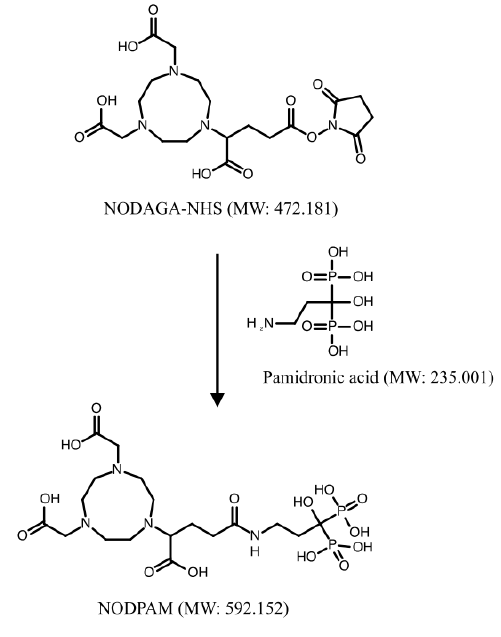
Figure 17. Conjugation of pamidronic acid and NODAGA ‐ NHS producing NODPAM.